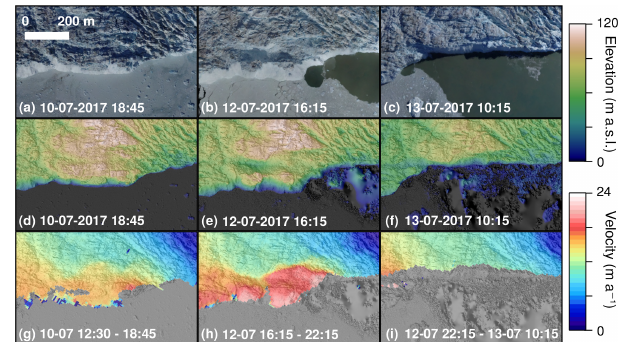
Figure 5. Orthophotos (a–c) , DEMs (d–f) , and velocity fields (e–i) showing the lead-up to and aftermath of a calving event that oc- curred on the south side of Store Glacier between 22:15WGST on 12 July and 10:15WGST on 13 July. Location is marked by the out- line in Fig. 3a. Note the poor reconstruction of open water visible in DEMs and hillshades of panels (e) , (f) , (h) , and (i) .